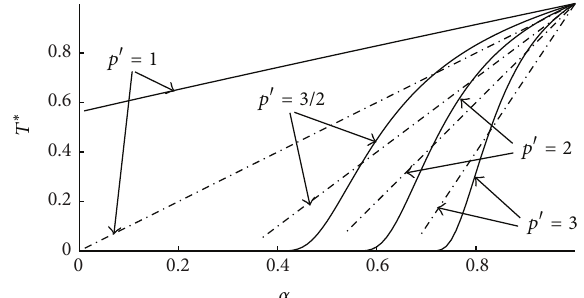
Figure 3: The dependencies for norm of control from 𝛼 at 𝑝 󸀠 = 3/2 (logarithmic scale used for ordinates).